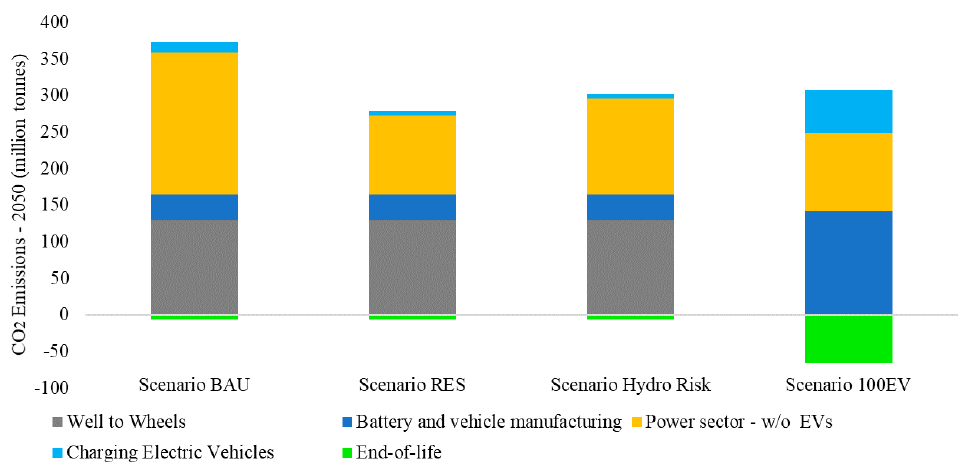
Figure 10. CO 2 for each scenario in 2050 (millions of tonnes).